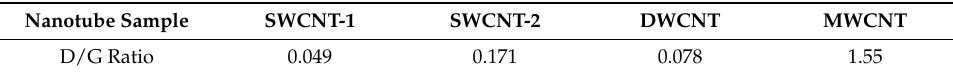
Table 1. D band to G band ratios for each nanotube type (two single-walled carbon nanotube samples (SWCNT-1 and SWCNT-2), one double-walled carbon nanotube sample (DWCNT) and one multi-walled carbon nanotube sample (MWCNT)).